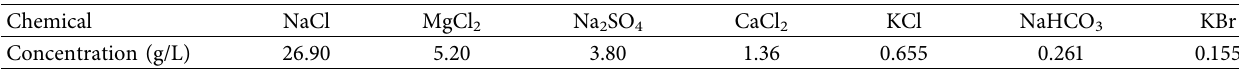
Figure 4: Samples after taking out from the Oman Sea. Table 6: Main chemical composition of Oman seawater.